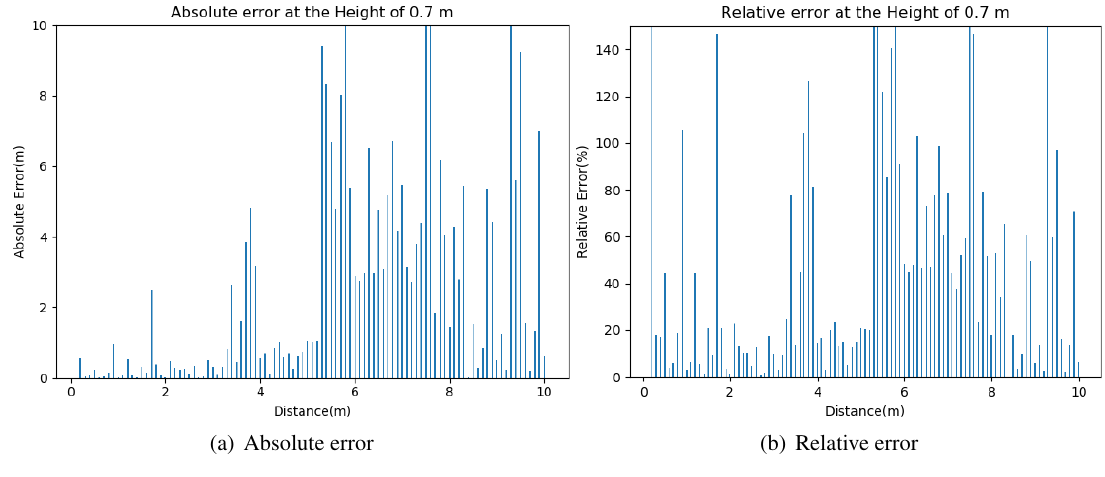
Fig. 3 Effect of Gaussian filter.